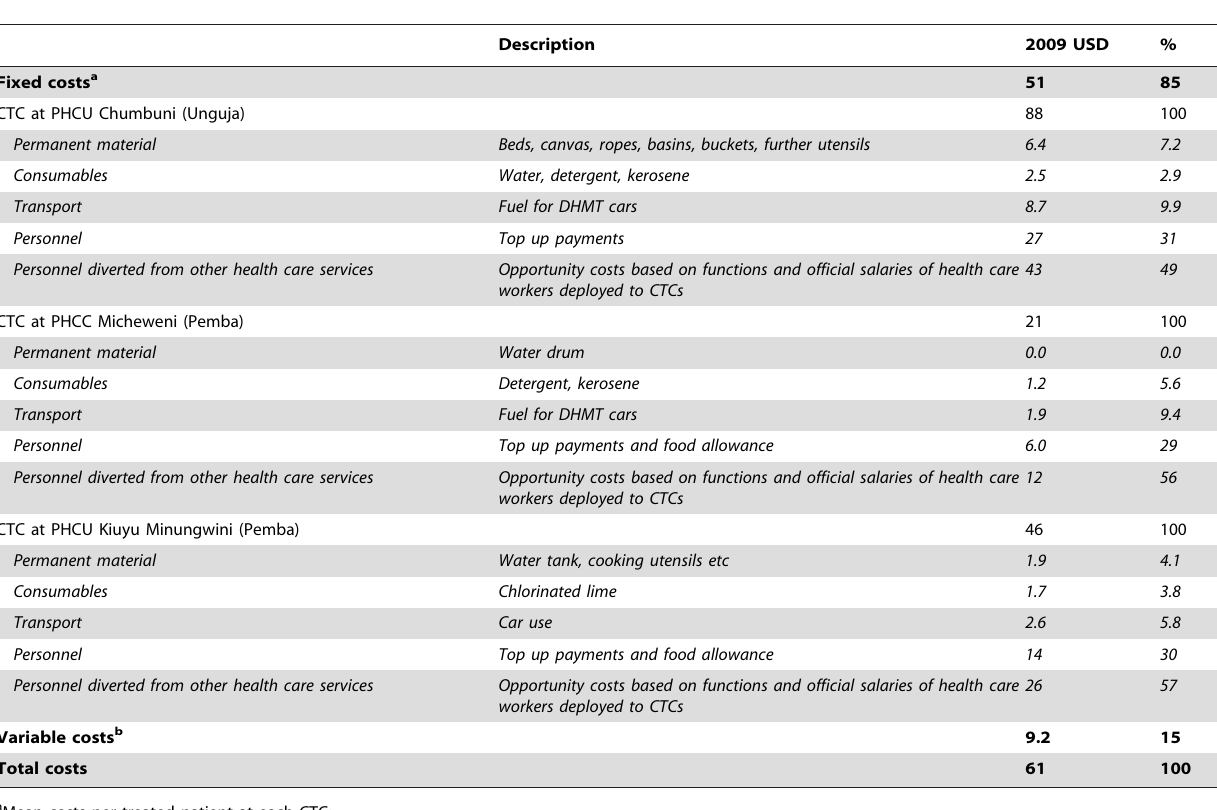
Table 3. Public costs of illness for cholera, Zanzibar, 2009.